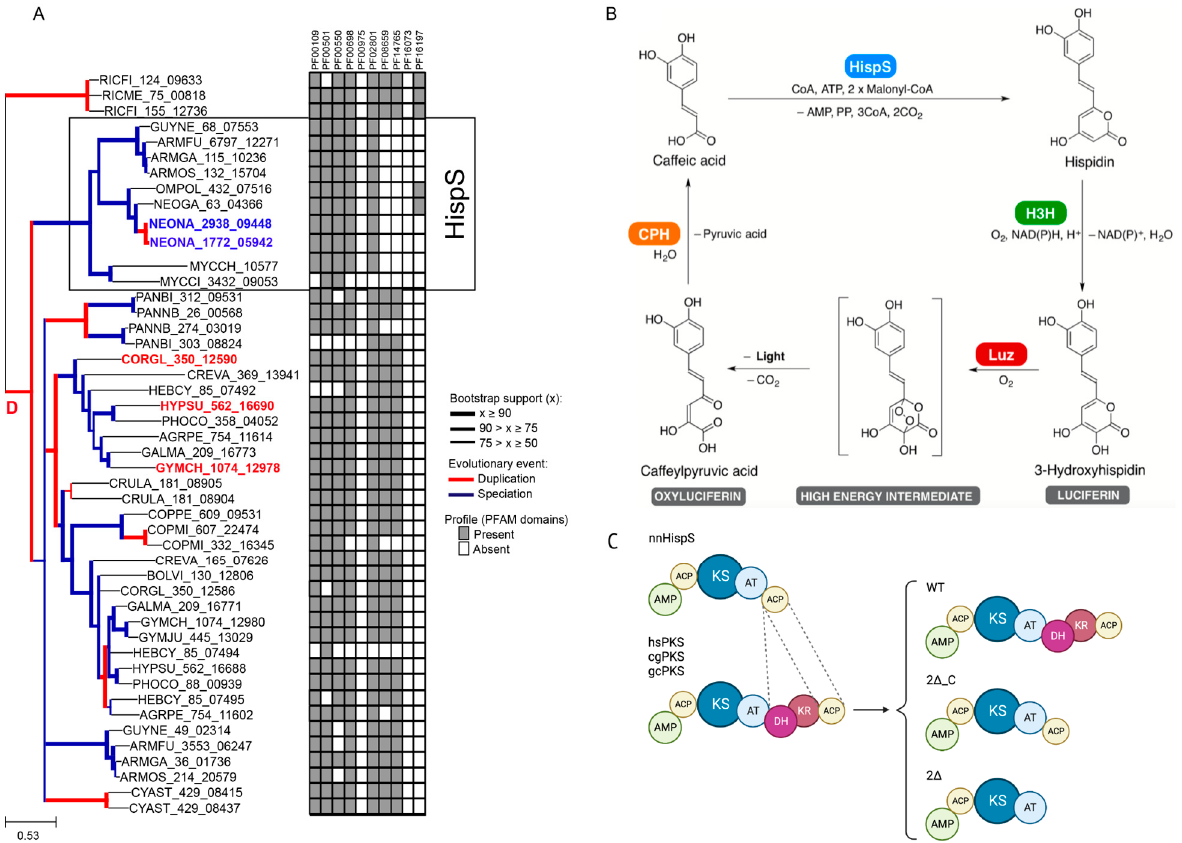
Figure 1. ( A ) Adapted from [9]. Polyketide synthase domain organisation in bioluminescent (marked with a rectangle “HispS”) and non-bioluminescent fungi. Genes selected for domain deletion analysis are shown in red; nnHispS is shown in blue. ( B ) Adapted from [9]. Caffeic acid cycle in bioluminescent fungi: hispidin is produced by a hispidin synthase (HispS), converted by a hispidin-3-hydroxylase (H3H) into luciferin, which is then oxidised by a luciferase (Luz), resulting in emission of light. Oxyluciferin is predicted to be converted back to caffeic acid by a caffeoyl private hydroxylase (CPH). ( C ) Schematic representation of the wild-type (WT) and truncated polyketide synthases from Cortinarius glaucopus (cgPKS), Hypholoma sublateritium (hsPKS), and Gymnopilus chrysopellus (gcPKS). 2 Δ denotes enzyme variants with deleted dehydratase, ketoreductase, and C-terminal acyl carrier protein domains; 2 Δ _C denotes enzyme variants where only the dehydratase